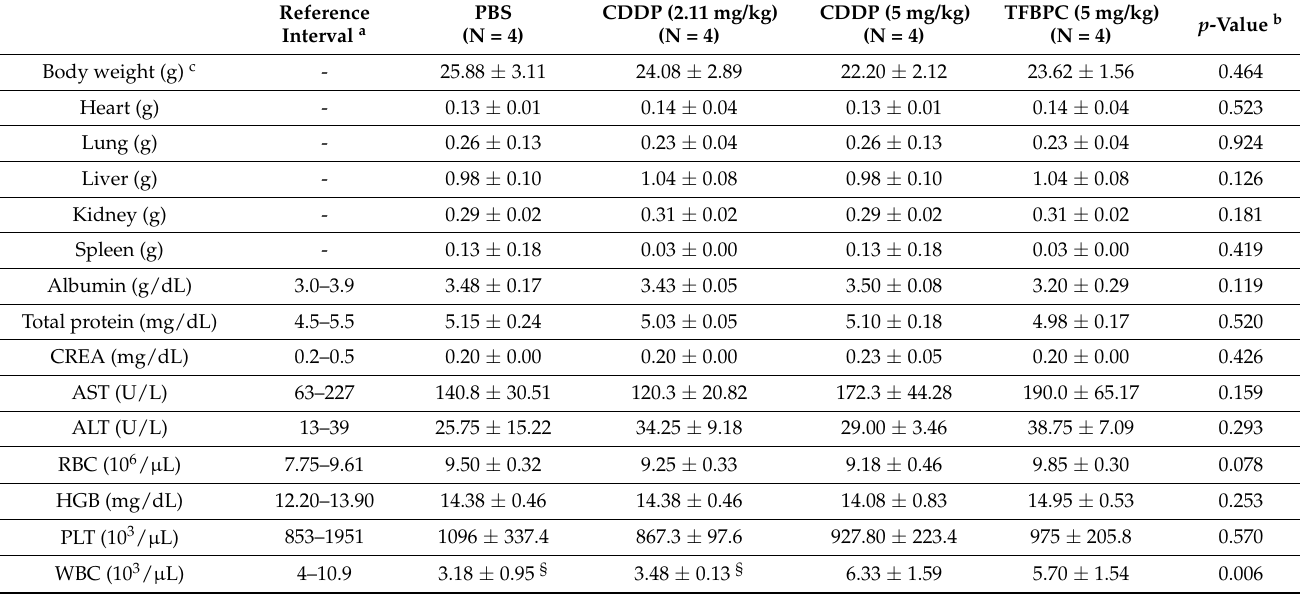
Table 3. Parameters of cancer-bearing xenograft